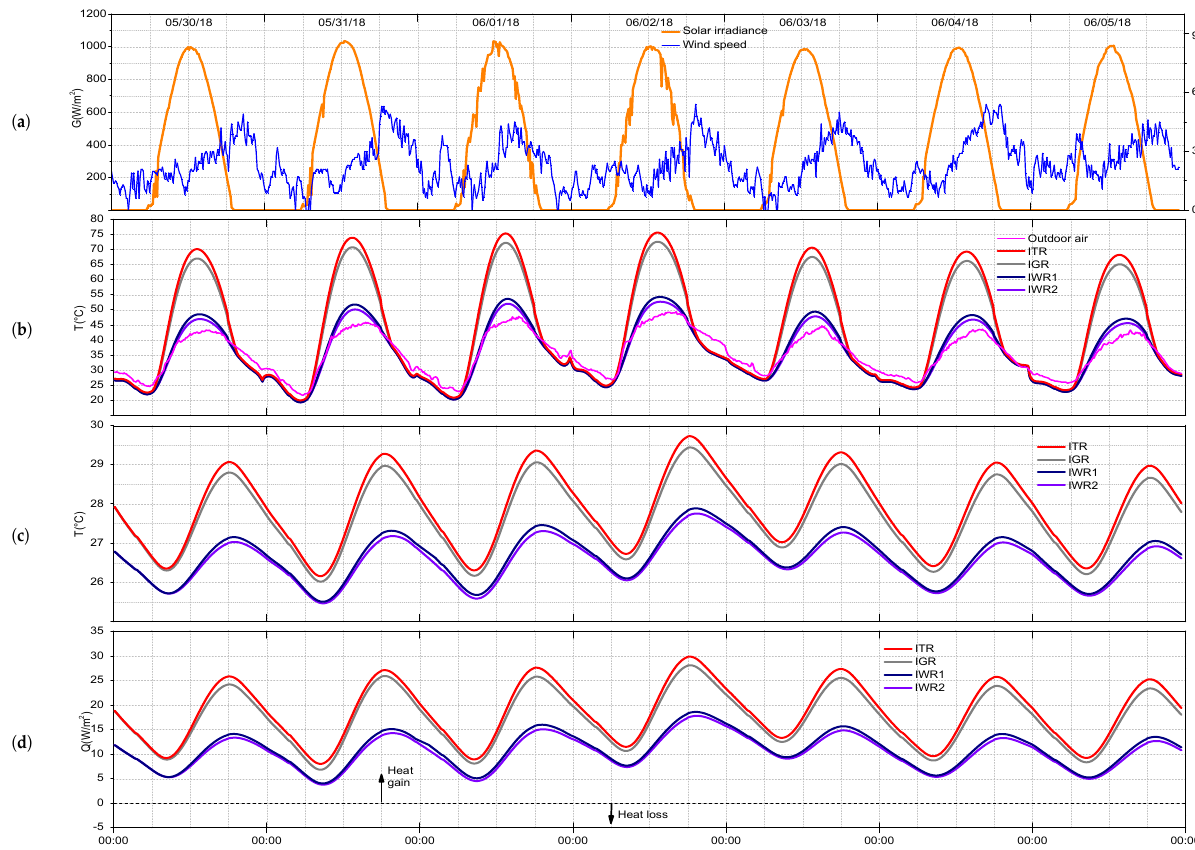
Figure 5. Thermal behavior of the insulated roof with traditional and reflective coatings in Hermosillo; ( a ) Solar irradiance and wind speed; ( b ) Temperature of exterior surface and outdoor air; ( c ) Temperature of interior surface; ( d ) Heat flux of the roofs.